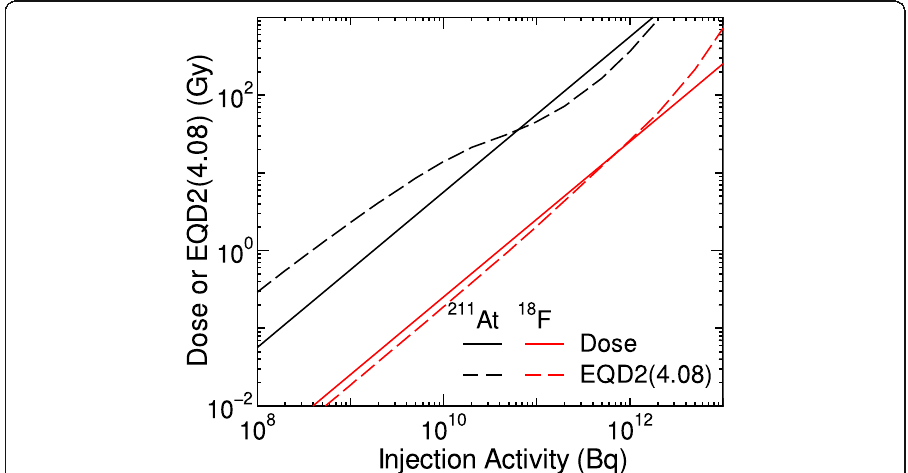
Fig. 5 Activity dependences of the calculated dose and EQD2(4.08) in the kidney for volunteer 1 with the injection of NKO-035 labeled with 211 At or 18